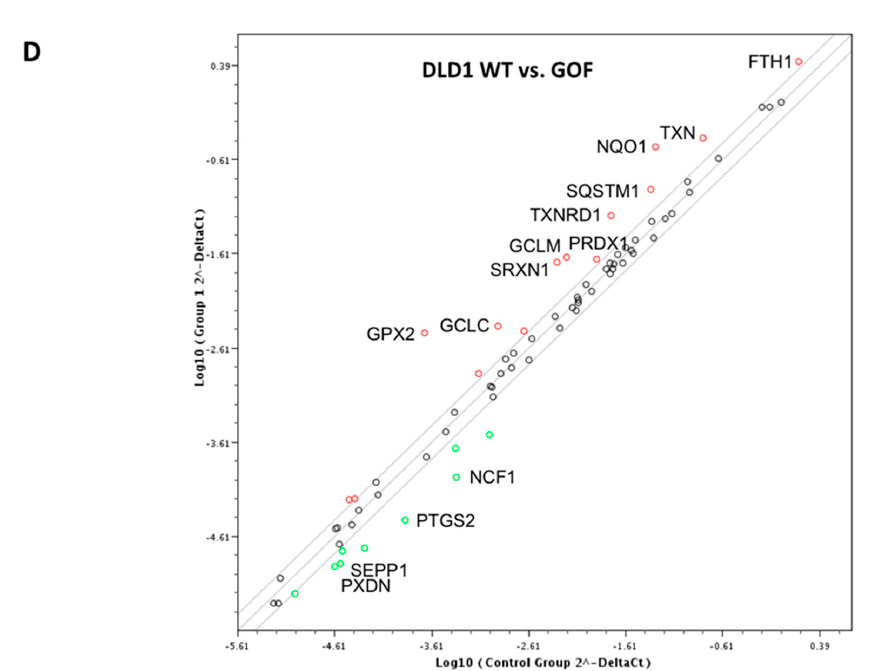
Figure 2. Validation of a new colorectal cancer NRF2-GOF (gain-of-function) in vitro model. ( A ) Schematic representation of the NRF2 domains and the sequencing on the NRF2-GOF clones. ( B ) Isogenic NRF2-WT (wild-type) and NRF2-GOF DLD1 cell lines were treated with either DMSO ( − ) or with 5 μ M of sulforaphane (SFN) (+) for 3 h, and the protein levels of NRF2 were compared. ( C ) The mRNA levels for NQO1 in the indicated cell lines treated with dimethyl sulfoxide (DMSO) or with 5 μ M of SFN for 16 h were quantified using real-time PCR. The data were normalised using β -actin as an internal control. Data represent means ± SD ( n = 3) and are expressed relative to the WT DMSO cells. ** p ≤ 0.01. ( D ) Representation of the differential expression of oxidative stress-related genes in NRF2 WT versus NRF2-GOF. Highlighted either in red (upregulated) or in green (downregulated) are genes with more than 2-fold changes; only those with p -values < 0.05 were labelled ( n = 3).